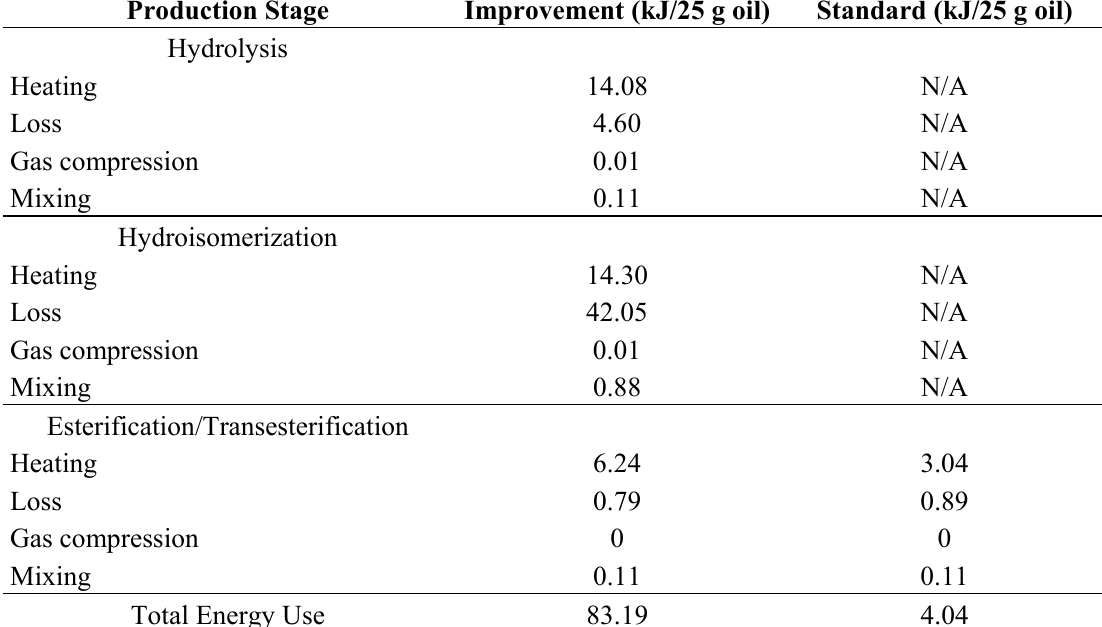
Table 5. Energy use comparison for the hydroisomerization improvement biodiesel production process versus the standard biodiesel